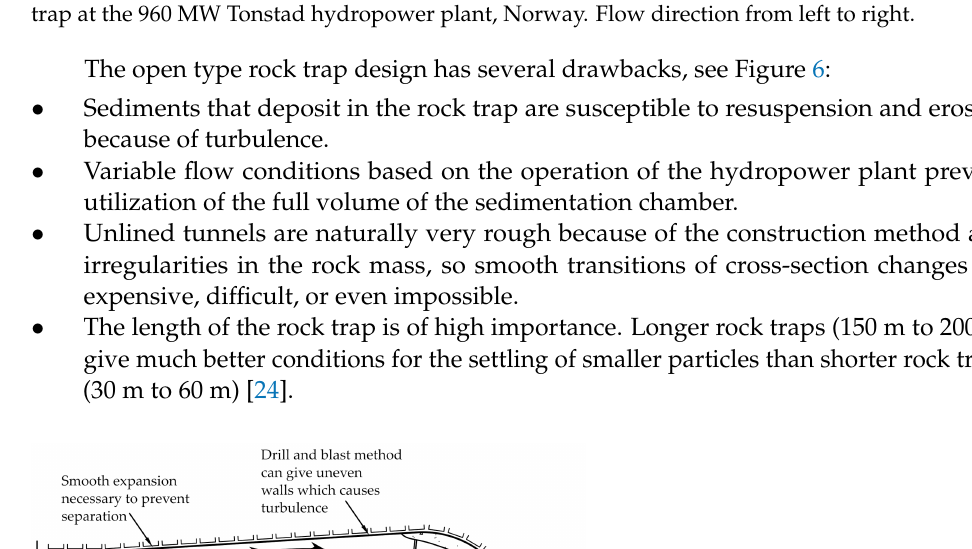
Figure 5. Picture of sediment deposited before the weir in the downstream end of a pressurized rock trap at the 960 MW Tonstad hydropower plant, Norway. Flow direction from left to right.